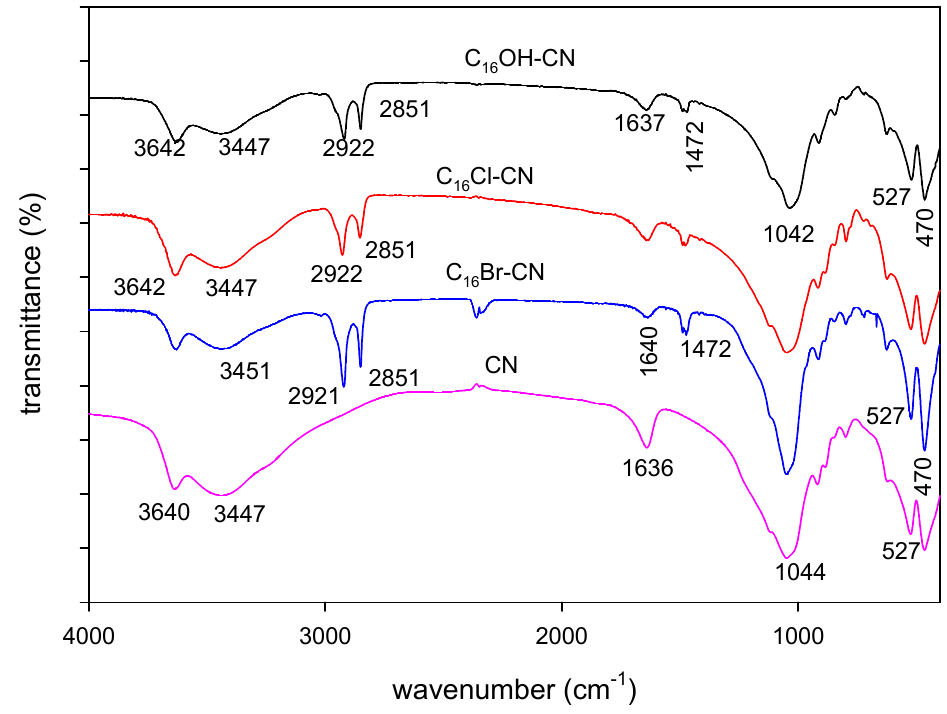
Figure 5. FTIR spectra of starting cloisite clay (CN) exchanged with different C 16 solutions.